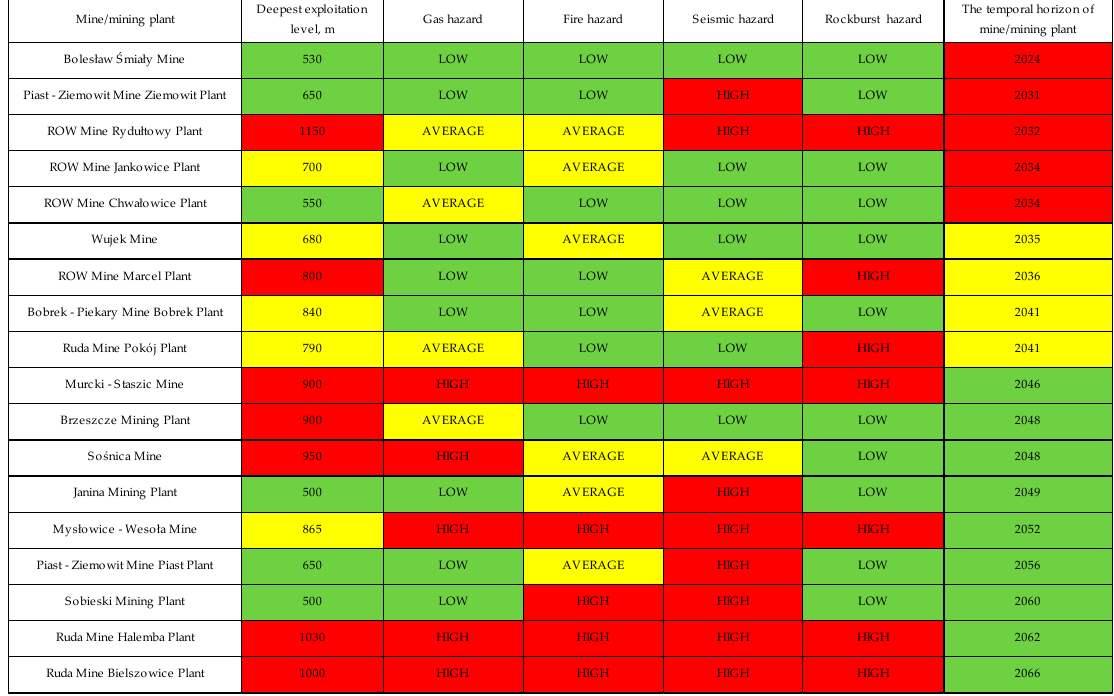
Figure 4. Summary of average inflows to mines/mining plants and the primary rock temperature, from the authors’ study.